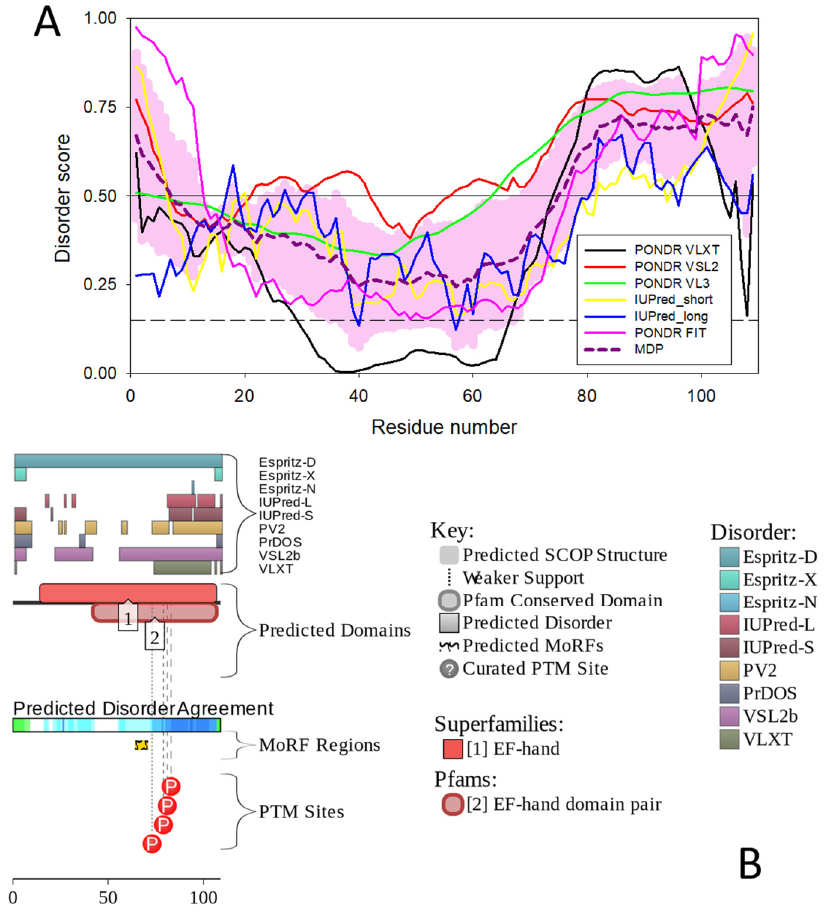
Figure 6. Evaluating intrinsic disorder status of human oncomodulin. ( A ) Intrinsic disorder profile generated using outputs of PONDR ® VLXT [128], PONDR ® VLS2 [129], PONDR ® VL3 [130], PONDR ® FIT [131], IUPred2 (Short), and IUPred2 (Long) [132,133]. The outputs of the evaluation of the per-residue disorder propensity by these tools are represented as real numbers between 1 (ideal prediction of disorder) and 0 (ideal prediction of order). Mean disorder prediction (MDP) was calculated by averaging the outputs of individual predictors. Light pink shadow shows distribution of errors of mean. A threshold of ≥ 0.5 was used to identify disordered residues and regions in query proteins, whereas a threshold of ≥ 0.15 was implemented to identify flexible residues. ( B ) Functional disorder profile of human oncomodulin based on the D 2 P 2 analysis [135]. Here, disorder propensity was evaluated based on the outputs of PONDR ® VLXT [127], PONDR ® VSL2 [129], IUPred [133,134], PV2 [136], PrDOS [137], and ESpritz [138] shown by nine colored bars representing the locations of disordered regions predicted by these tools. Agreement between these predictors is shown by the blue–green–white bar, where darker blue and green parts correspond to the stronger disorder con- sensus. Lines with colored and numbered bars show the positions of the predicted SCOP domains [139,140] using the SUPERFAMILY predictor [141]. Yellow zigzagged bar shows the location of the predicted disorder-based binding site (MoRF regions) identified by the ANCHOR algorithm [142]. Red circles represent location of phosphorylation sites based on the outputs of the PhosphoSitePlus platform [143].